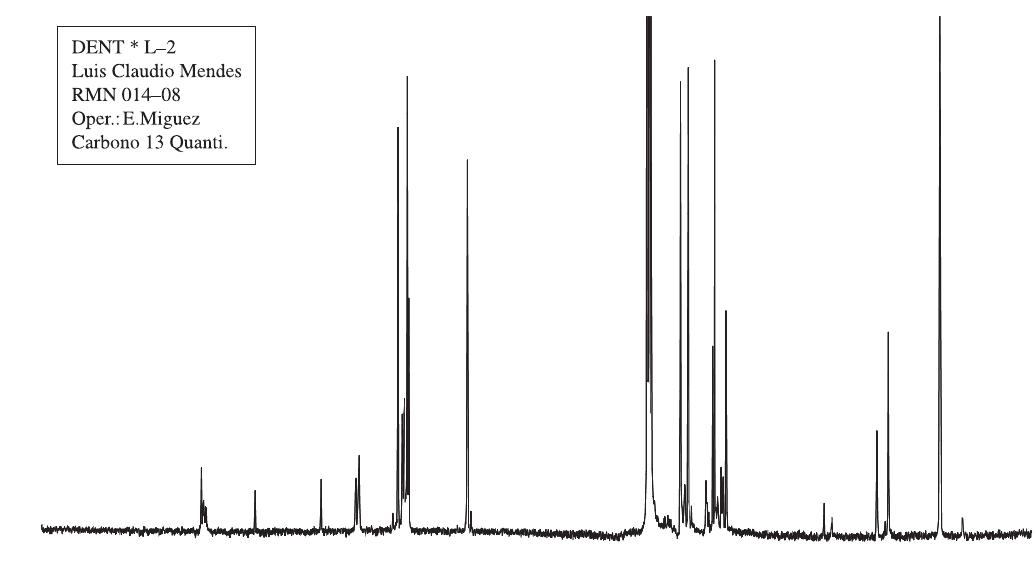
Figure 1. 13 C NMR spectrum of the cement solid portion.